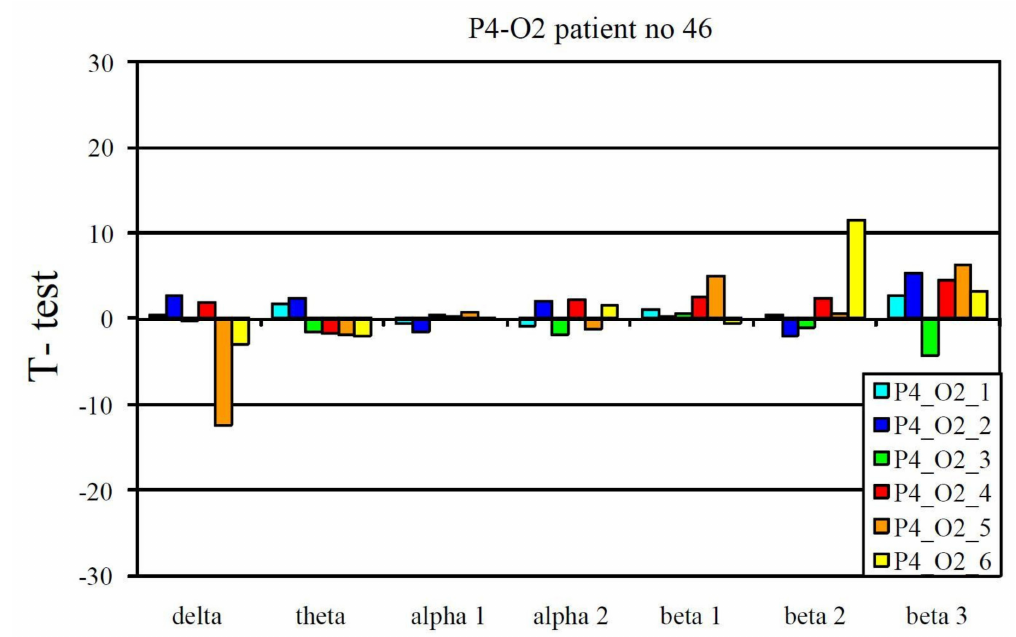
Figure 3. A positive pharmaco-EEG profile during selective serotonin reuptake inhibitor